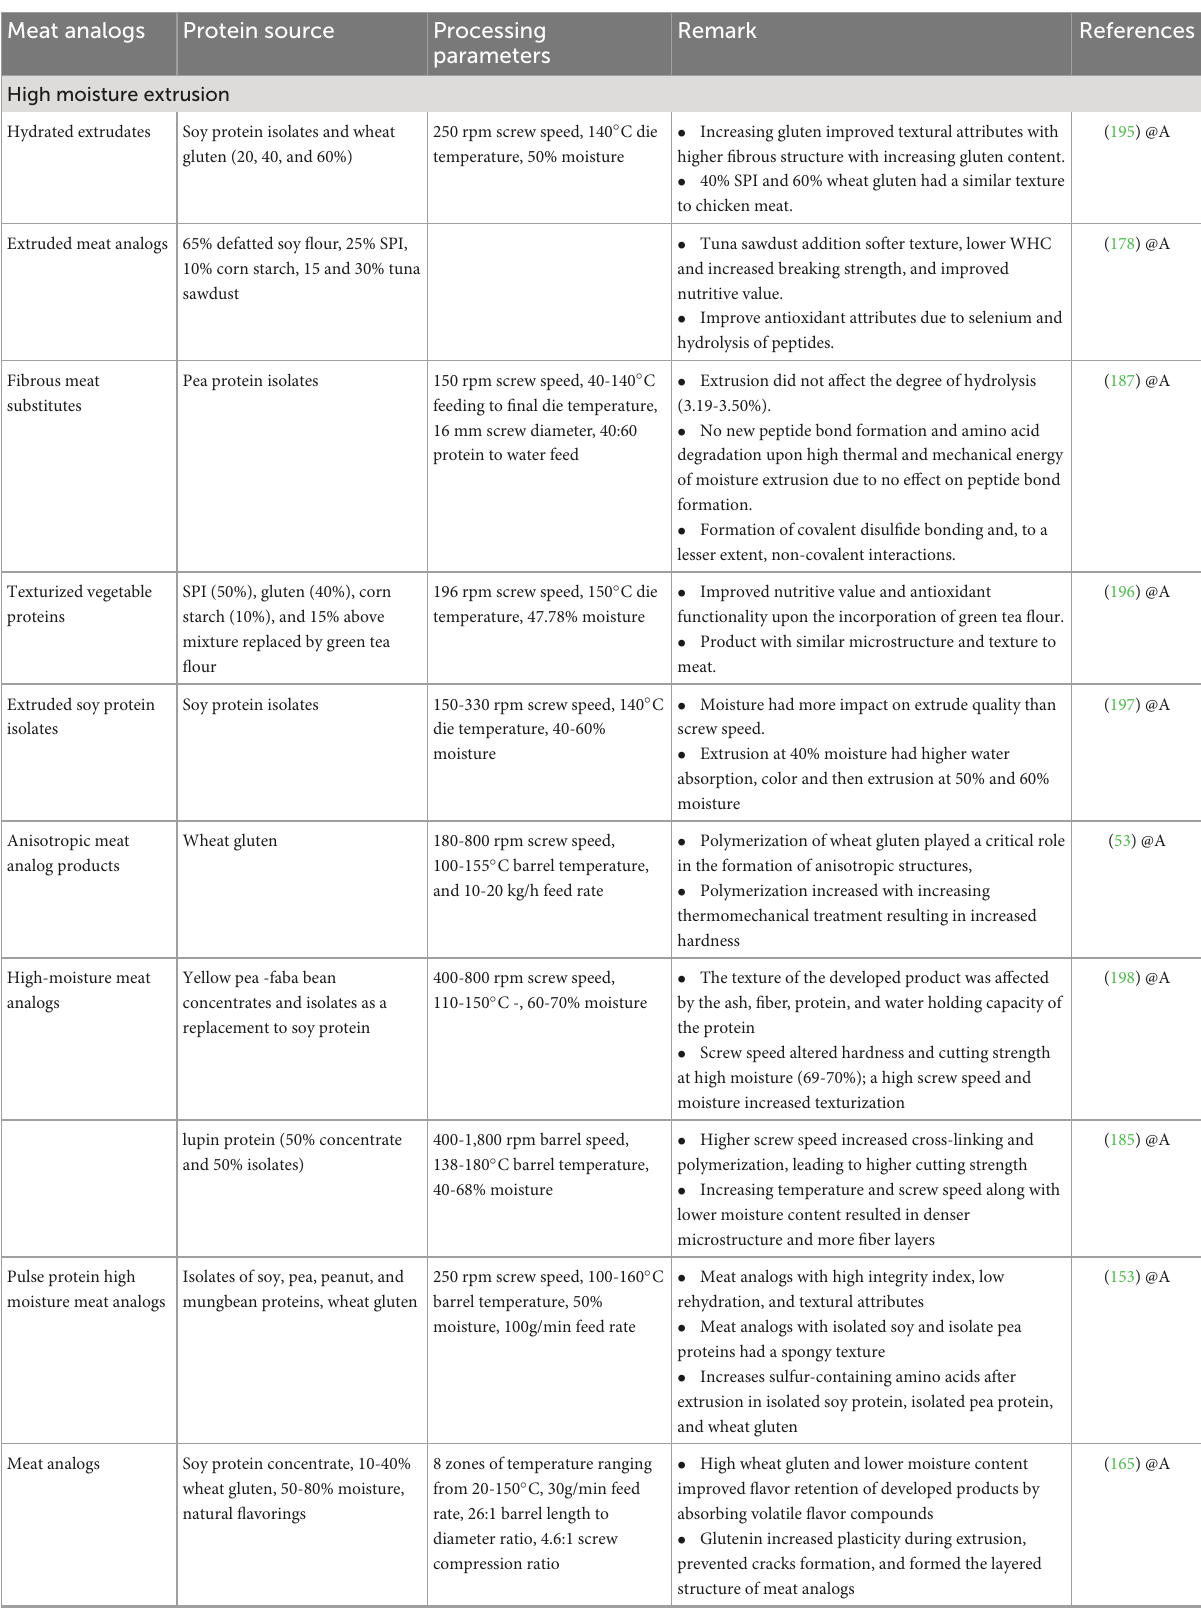
TABLE 3 Processing of proteins in formulation and processing of meat analogs. Meat analogs Protein source Processing